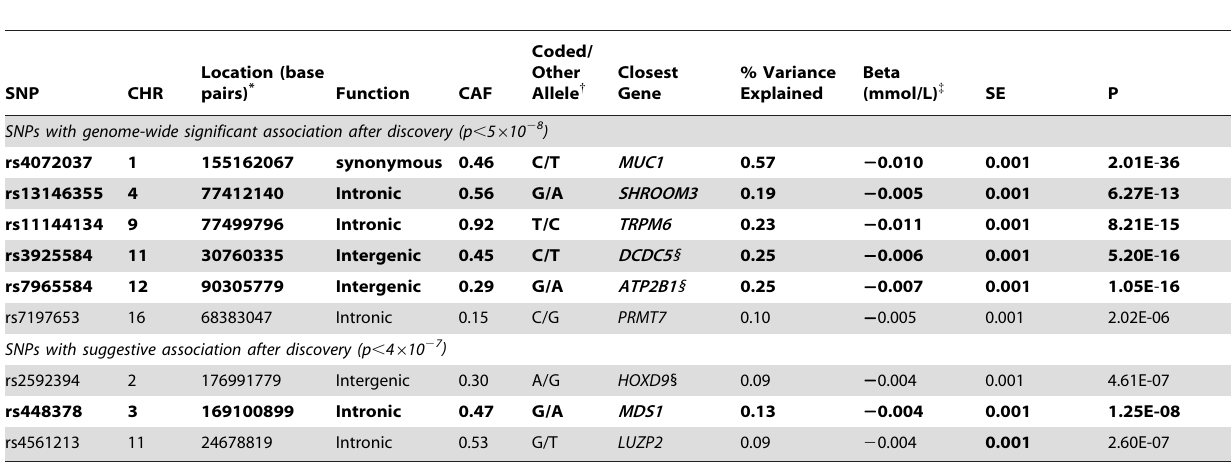
Table 2. Associations between serum magnesium levels and the lead regional genome-wide significant SNPs in the combined discovery (N =15,366) and replication (N= 8,463) samples.